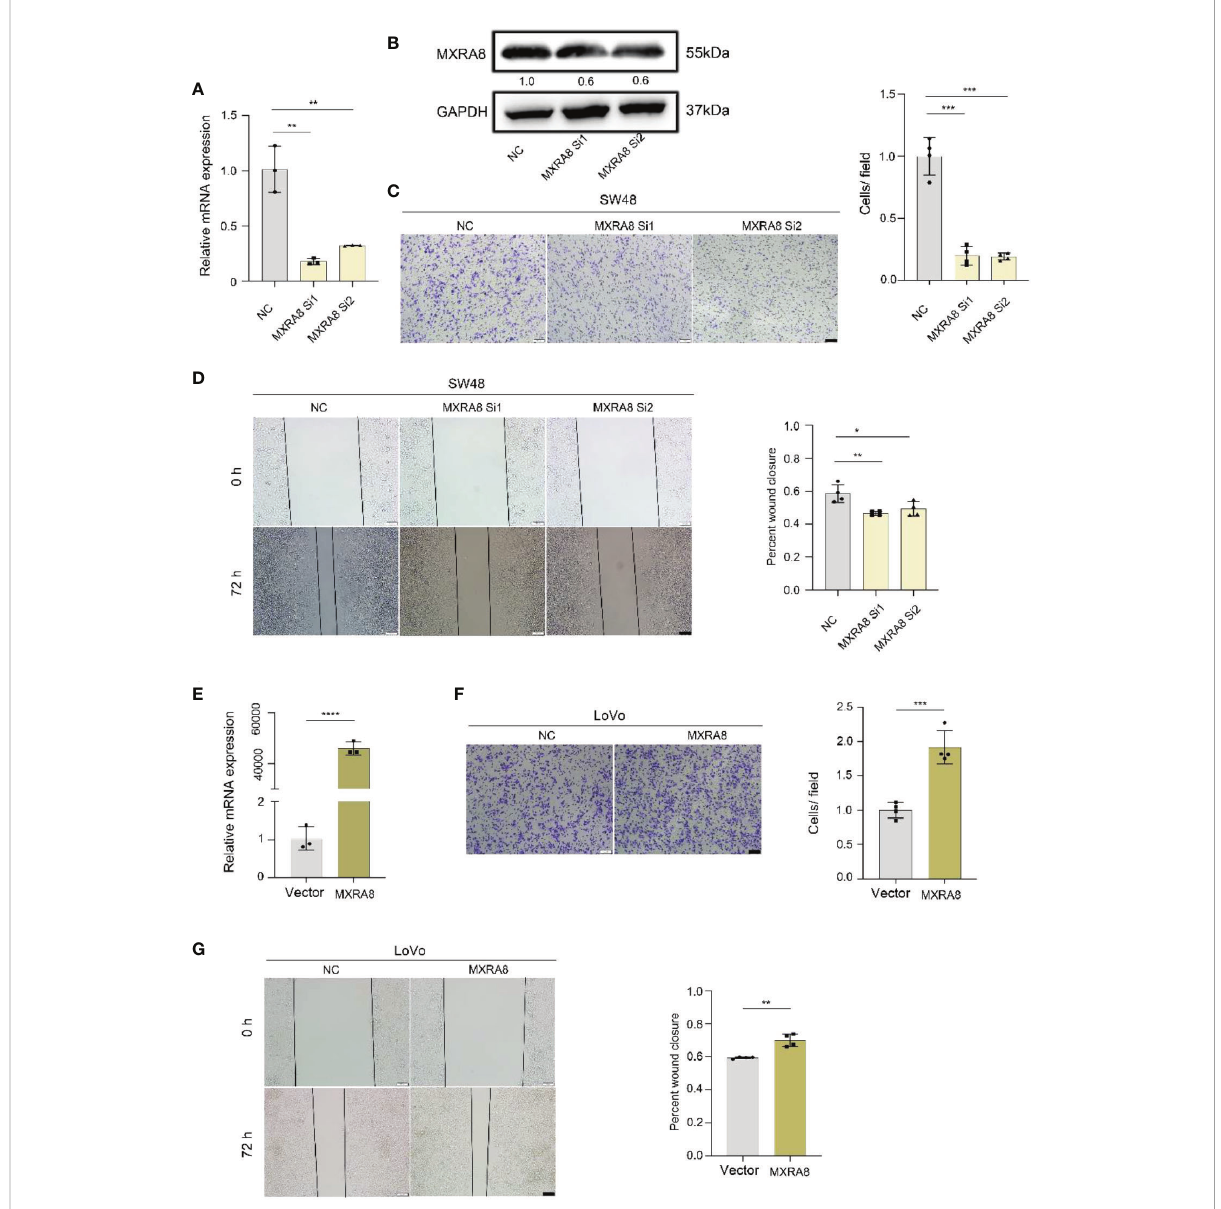
FIGURE 5 MXRA8 promotes CRC cell invasion and migration in vitro . (A-D) Levels of MXRA8 mRNA, MXRA8 protein, images of transwell assay for migration, and wound healing assay in SW48 transfected with MXRA8 siRNA. (E-G) Levels of MXRA8 mRNA, images of transwell assay for migration, and wound healing assay in LoVo with MXRA8 plasmid transfection. ****p<0.0001; ***p<0.001; **p<0.01;